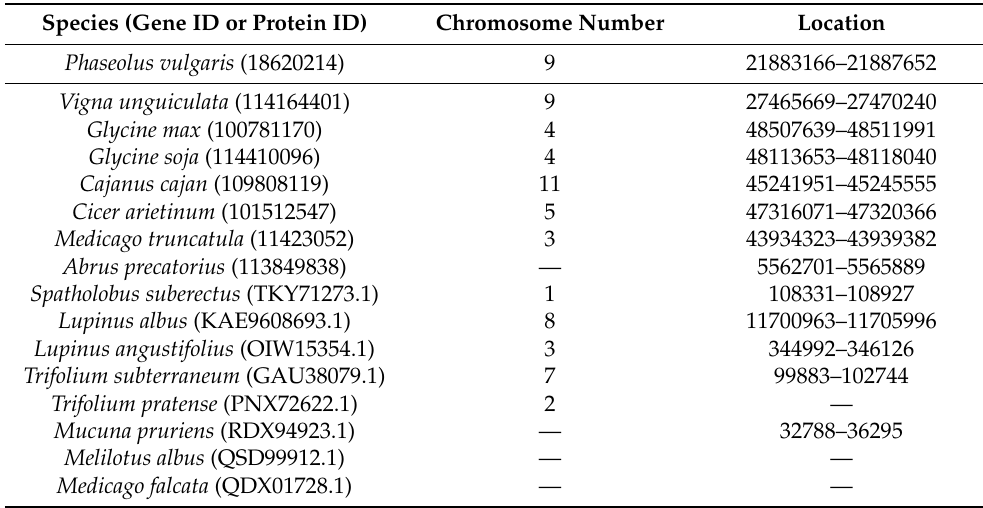
Table 1. Chromosomal locations of the NAC gene on the reference genomes in a total of 16 species of plants based on the National Center for Biotechnology Information (NCBI) database. Symbol “—” indicates unknown